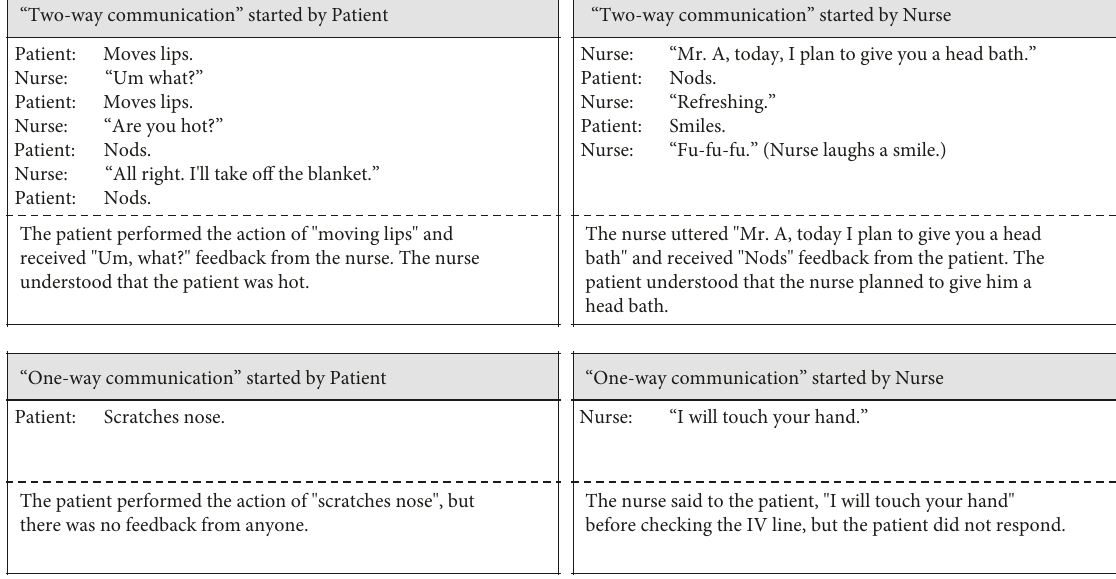
Figure 4: Examples of two-way and one-way communication scenes. The second row of each box shows the actual communication between the patient and the nurse. In the boxes showing one-way communication, only the actions of the patient or the nurse are displayed. The third row of each box shows the explanation of